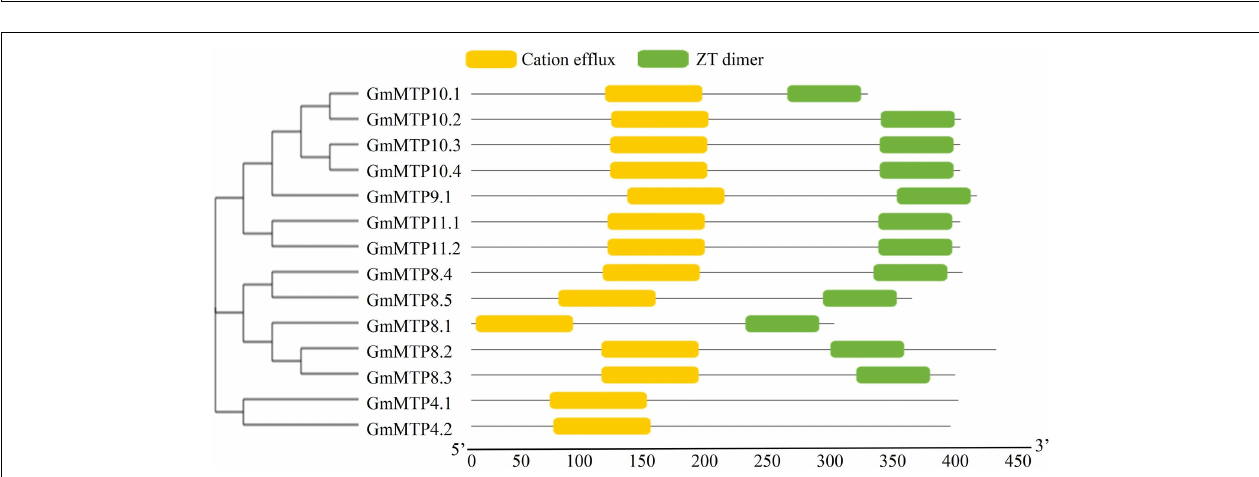
FIGURE 2 | Conserved motifs in GmMTPs. Yellow and green boxes indicate cation efflux and ZT dimer motifs, respectively. The neighbor-joining phylogenetic tree of GmMTPs was constructed using MEGA4.1.